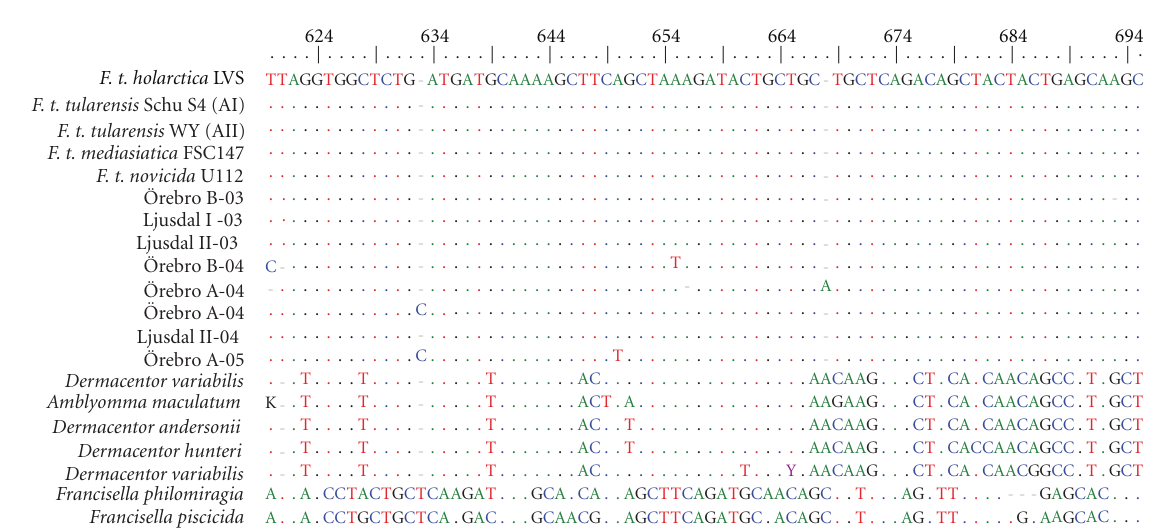
Figure 3: Multiple alignment of lpnA sequences obtained from Ljusdal and ¨Orebro with previously published sequences of Francisella species and subspecies and Francisella -like endosymbionts (FLE). The nucleotide positions 620 to 695 refer to F. t. holarctica LVS (M32059). Reference sequences from GenBank: F. t. holarctica LVS (M32059), F. t. tularensis strain WY96-3418 (CP000608), F. t. tularensis strain Schu